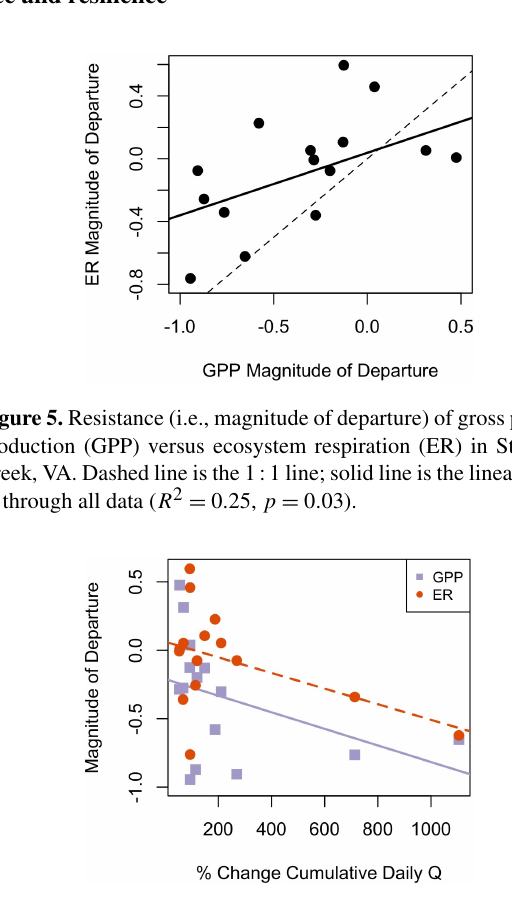
Figure 6. Flow event magnitude (percent change in cumulative daily discharge ( Q ) relative to the day prior) was negatively cor- related with magnitude of departure ( M ) for gross primary produc- tion (GPP; R 2 = 0 . 10, p = 0 . 143) and ecosystem respiration (ER; R 2 = 0 . 18, p = 0 . 066). The solid purple line is the regression line for the relationship between M GPP and percent change in discharge, while the dashed orange line is the regression line for the relation- ship between M ER and percent change in